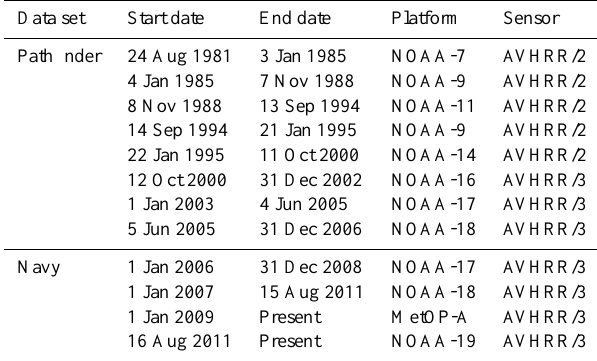
Table 2. Platform time spans of AVHRR inputs to the daily OISST. Note that two satellites at a time are used beginning January